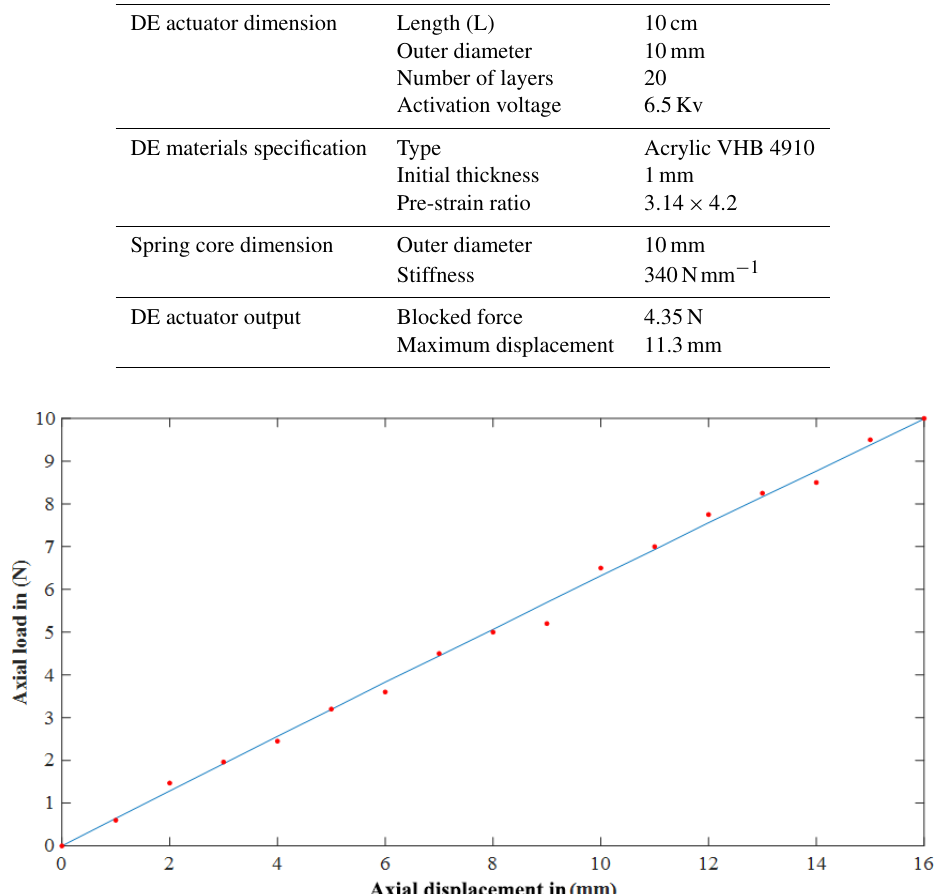
Figure 9. The result of the uniaxial tension test.